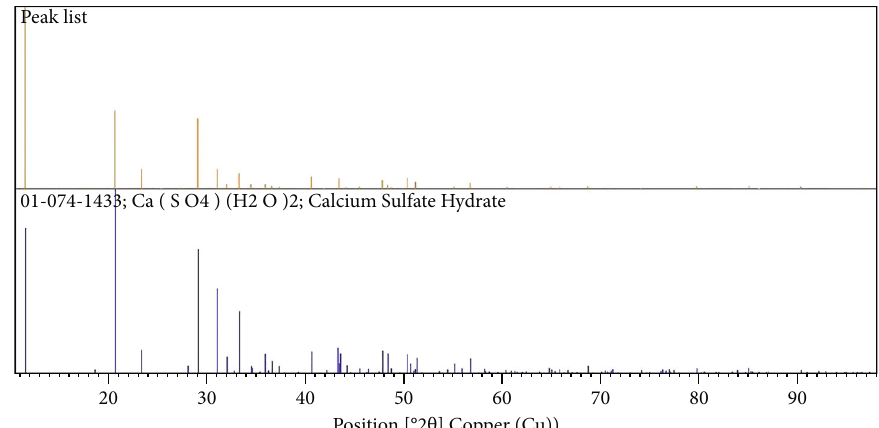
Figure 3: Peak list waste gypsum powder and the reference sample.